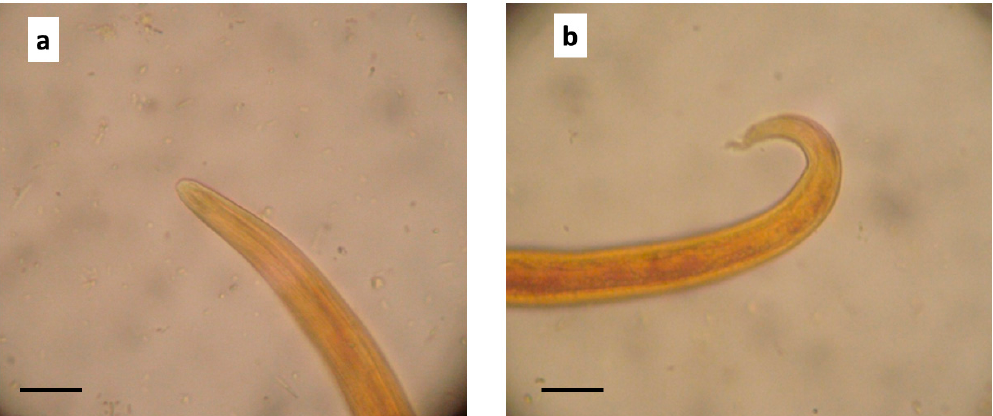
Figure 3. Aelurostrongylus abstrusus first stage larva (L1) in the Baermann examination of the kitten faecal sample. ( a ) Anterior end, ( b ) posterior end showing the S-shaped tail. 400x, (scale bar = 20 μ m). Based on the clinical, parasitological, and molecular results, a parasitic bronchopneumonia caused by A. abstrusus infection, with secondary severe PH and R-CHF, was diagnosed.